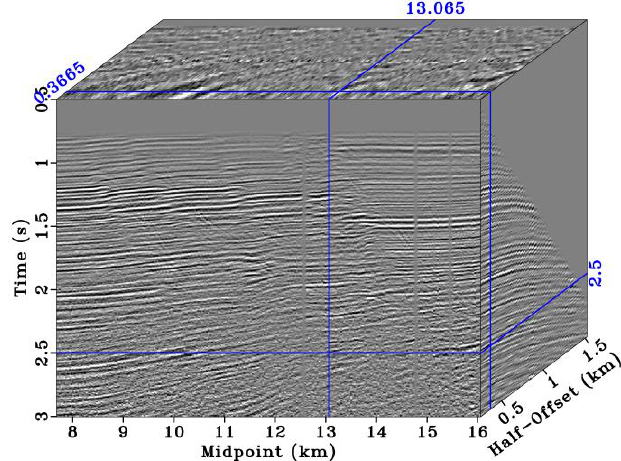
Figure 8. A field data with 250 CMP gathers from the Gulf of Mexico.